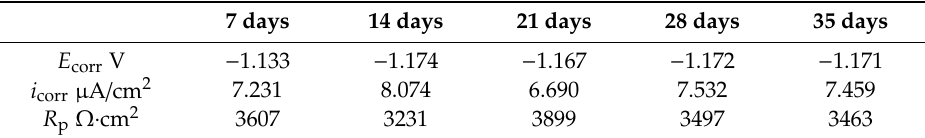
Table 5. Parameters of polarization curves with different immersion time.